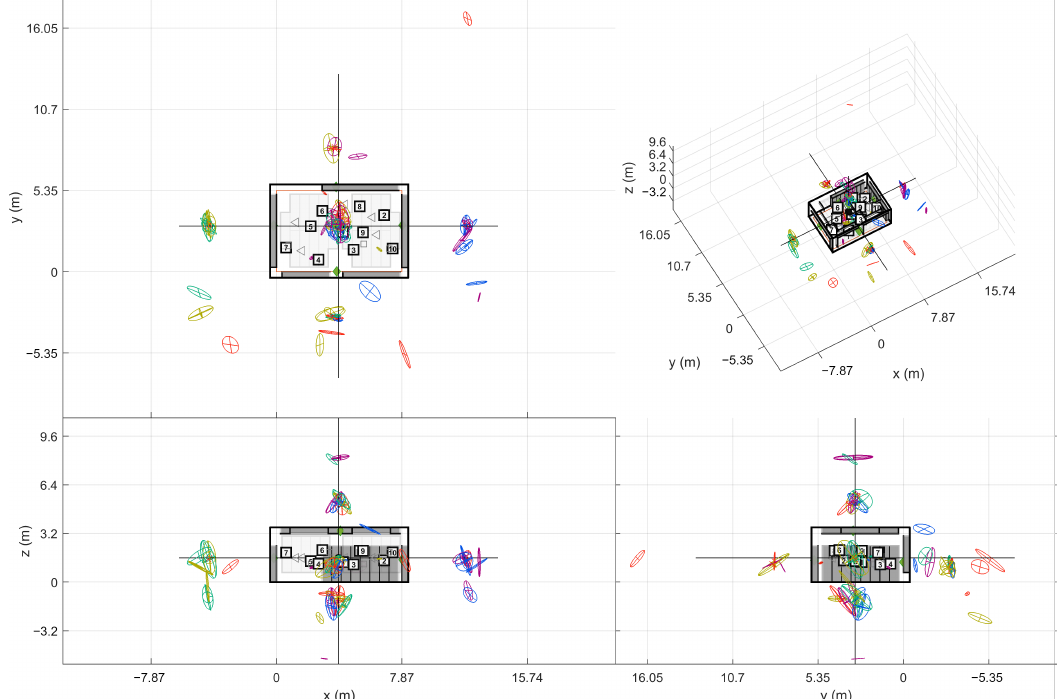
Figure A2. Centered source plot for variable acoustics room Arni (min. 3 ER objects per image source). The image sources from different sound sources are plotted with their own colors. The found reflections appear to form distinct groups where the corresponding image sources would to